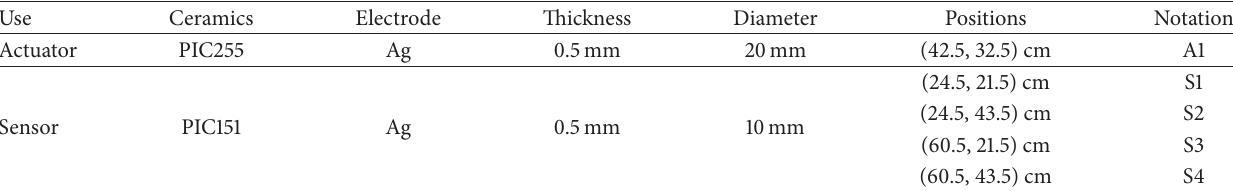
Table 2: Properties and positions of piezoelectric sensors and actuators.